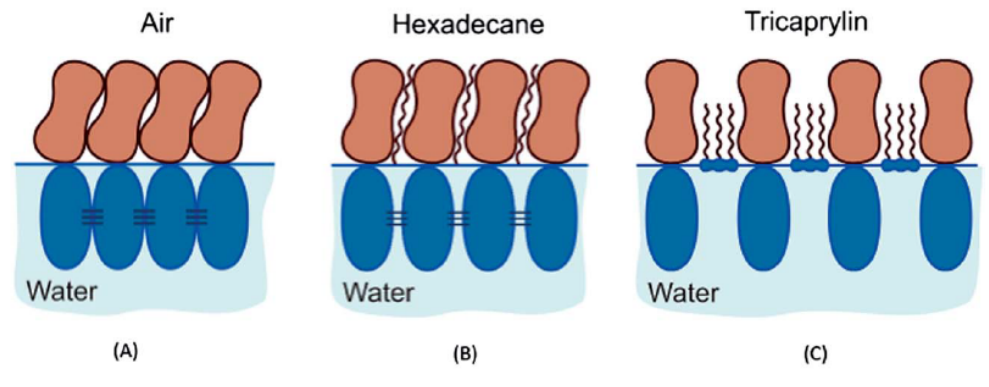
Figure 4. Proposed structure of saponin adsorption layers ( A – C ) for a monodesmosidic saponin